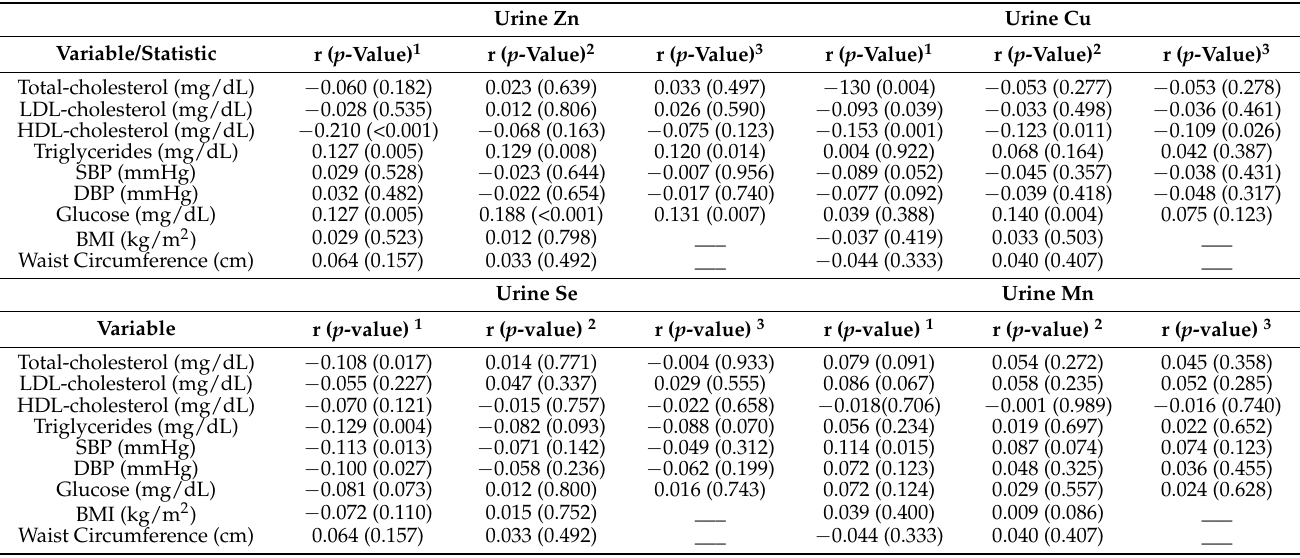
Table 3. Single association between urine levels of trace elements and cardiovascular risk factors (as